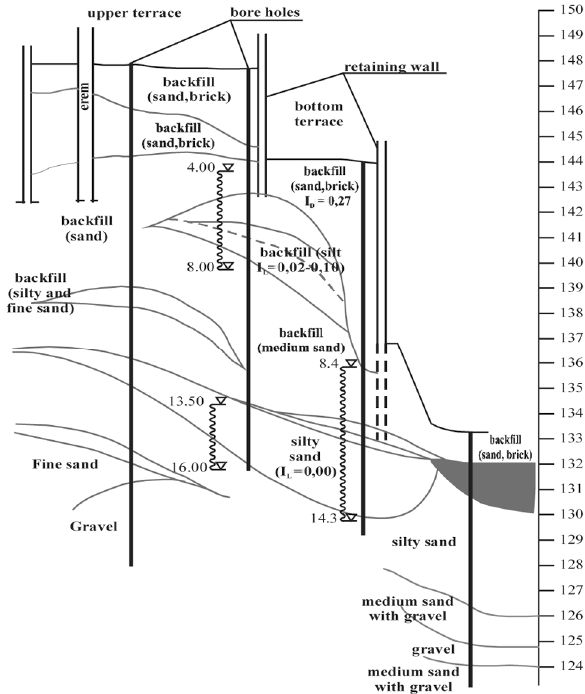
Fig. 6. Geological sections of the